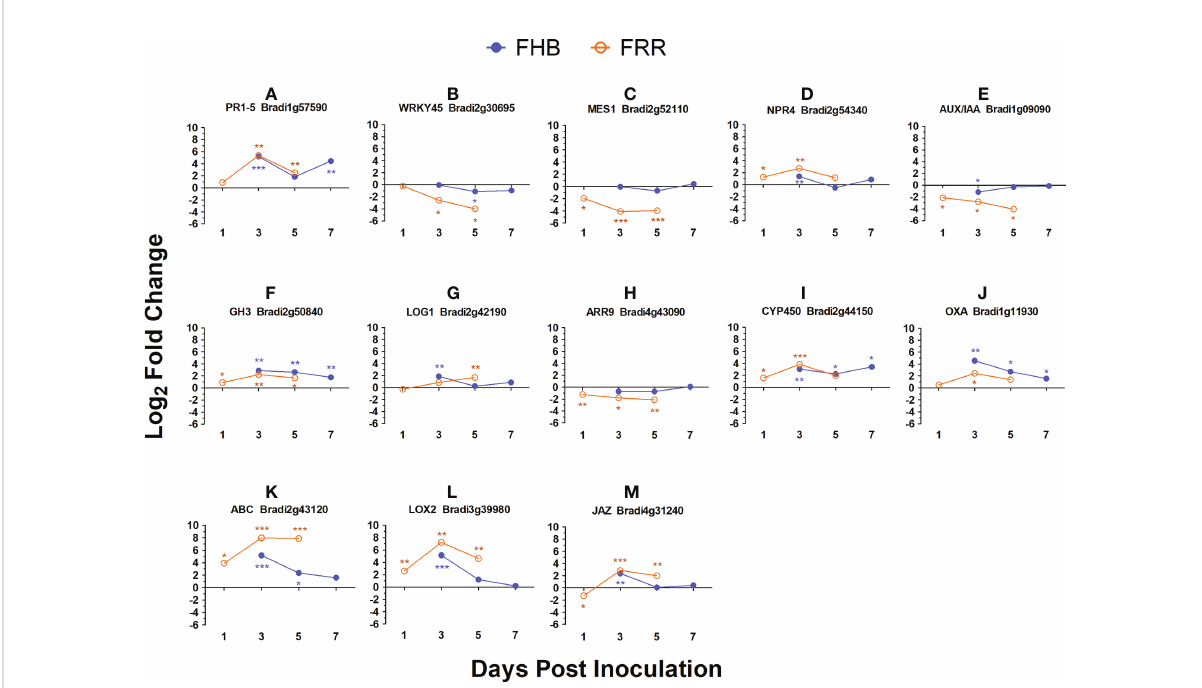
FIGURE 6 Expression time-course of differentially expressed B. distachyon genes in FHB and FRR. The blue lines denote FHB and orange lines denote FRR. The Log values presented are calculated by comparing infected tissue against mock-inoculated treatments. The reference housekeeping gene GAPDH was used. Each point is the average of three biological replicates and 2-3 technical replicates. Levels of signi fi cance relative to the mock-control, Cq t-test *p<0.05, **p<0.01, ***p <